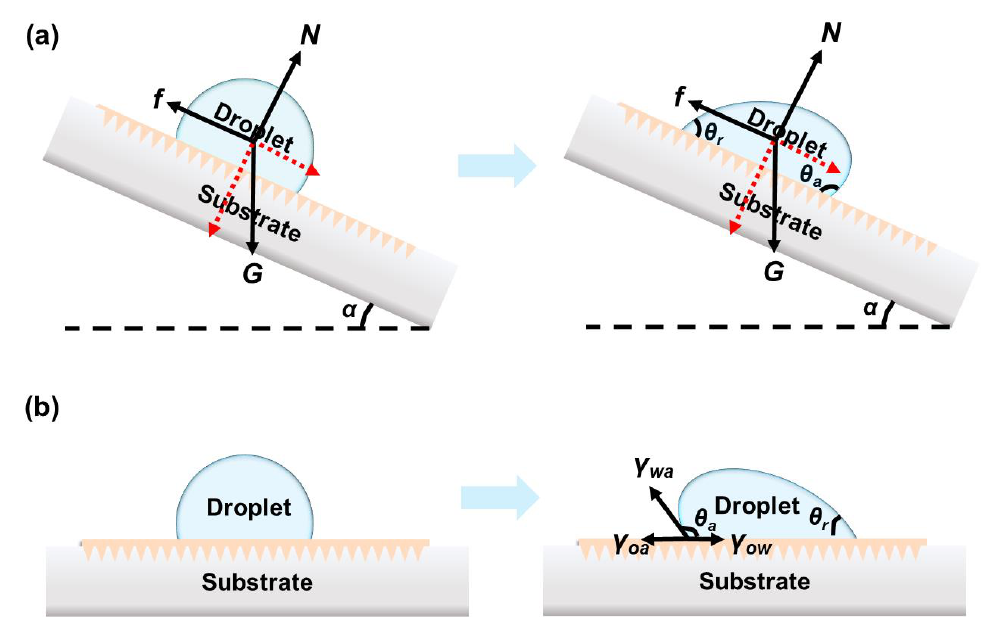
Figure 3. ( a ) Force analysis of the droplet on tilted LIS. N, f, G and α refer to the normal force, resistance induced by contact angle hysteresis, gravity and tilted angle, respectively. ( b ) Scheme of the driving force generated by the surface tension difference on the droplet to slide at flat LIS.